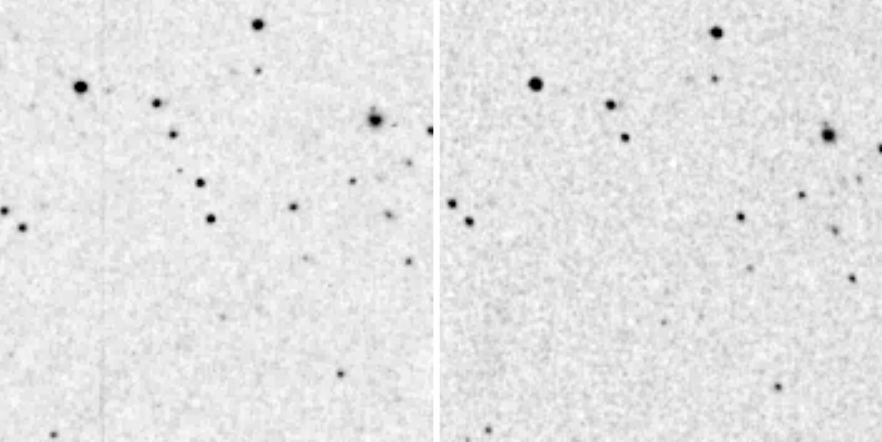
Figure 1. An example of an anomalous observation found by VASCO. Two sources disappear within a short time. The left POSS-I E (red) image was taken in the early spring of 1950. The right POSS-I E (red) image was taken six days